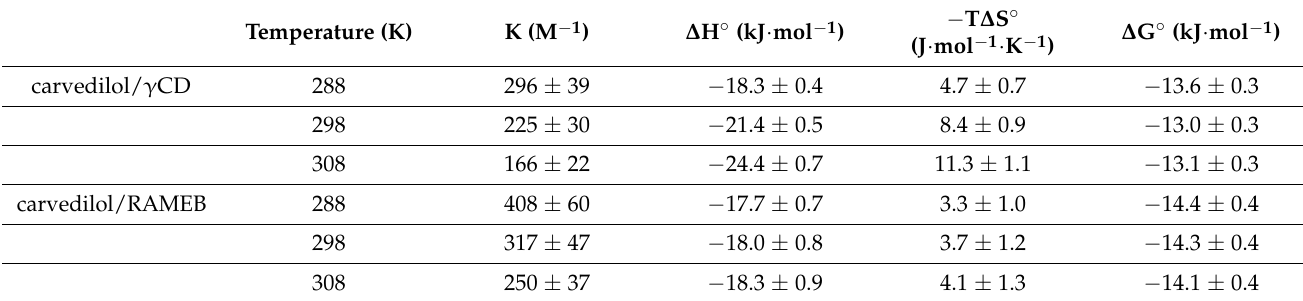
Table 3. Thermodynamic parameters obtained by ITC for the carvedilol/ γ CD and carvedilol/RAMEB systems. Temperature (K) K (M − 1 ) carvedilol/ γ CD 288 296 ± 39 carvedilol/RAMEB